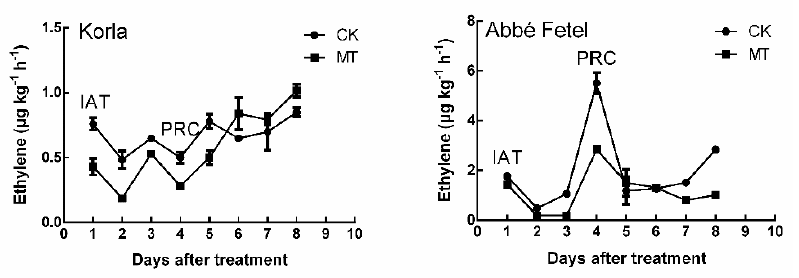
Figure 1. Effect of melatonin on ethylene production during storage. CK: negative control; MT: 100 μ M melatonin; data are means of 5 replicates ± SD.